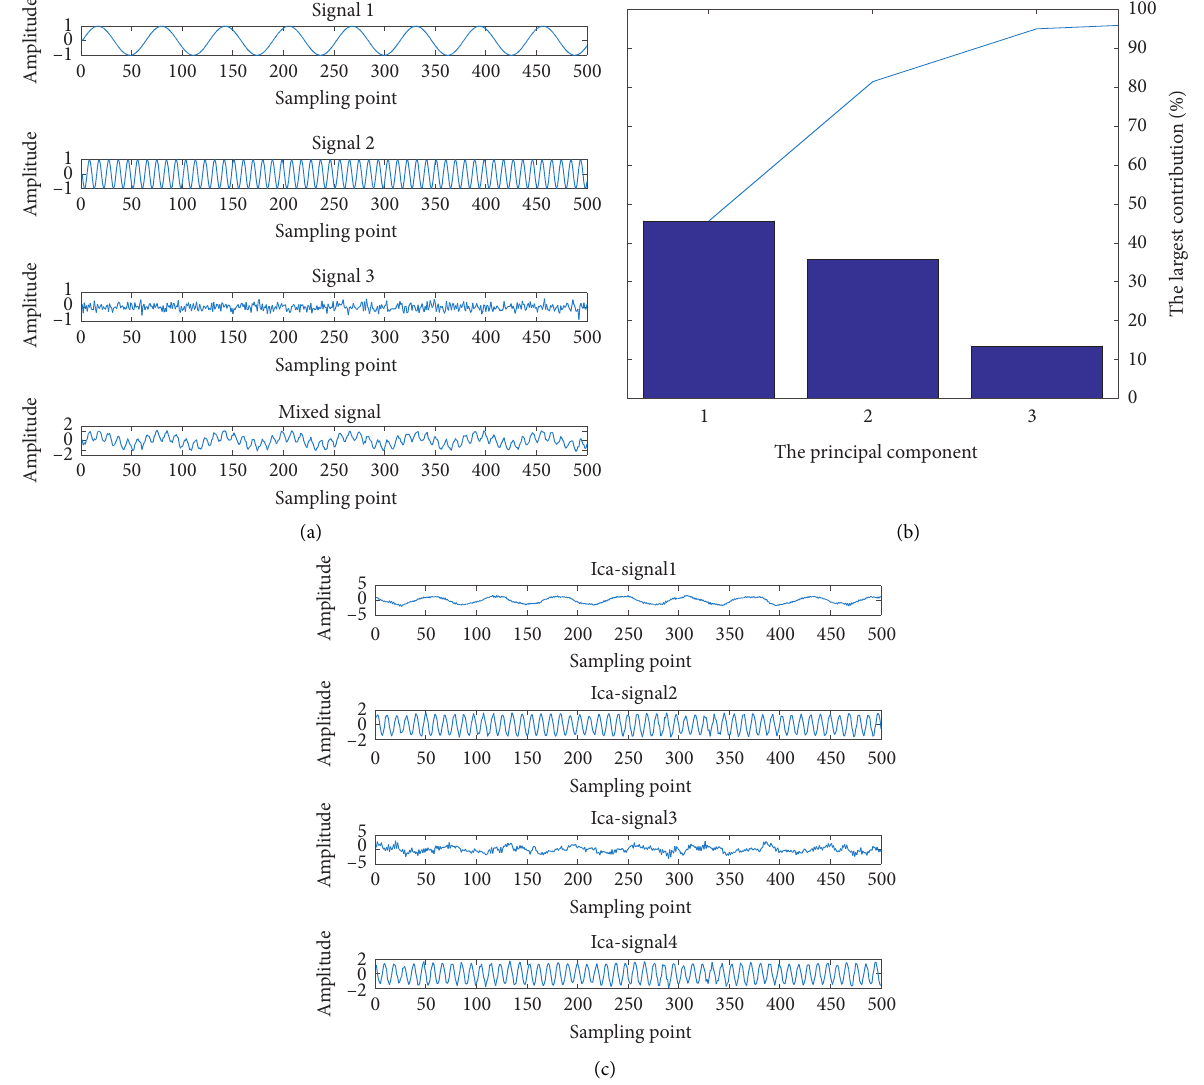
Figure 3: Noise added condition. (a) Original and combined signal, (b) PCA variance (with noise), and (c) separation results.